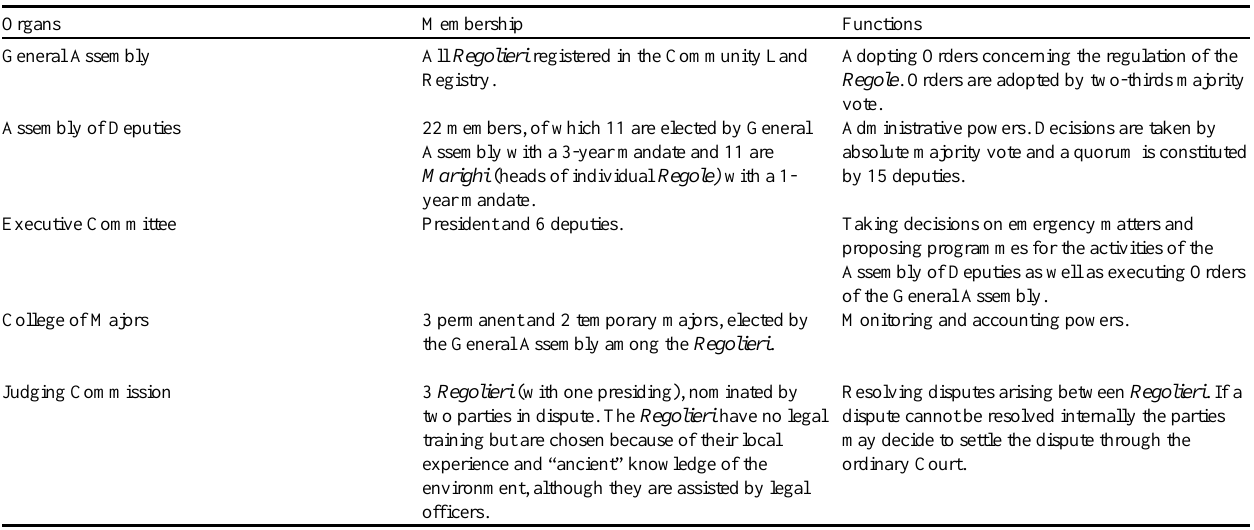
Table 1 . Organs and functions of the Regole's customary governance